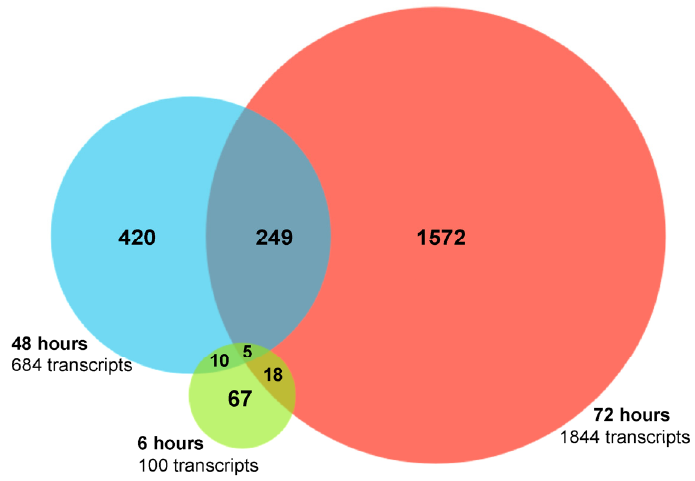
Figure 1. Differentially expressed annotated genes after acute hepatitis C virus (HCV) infection of Huh 7.5 cells. A Venn diagram depicting the number of genes that are differentially expressed (FDR > 13 and fold change  1.5) at 6, 48, and 72 hours after HCV JFH-1 infection are shown. Genes that were significantly differentially expressed at more than one time point are shown in the overlapping